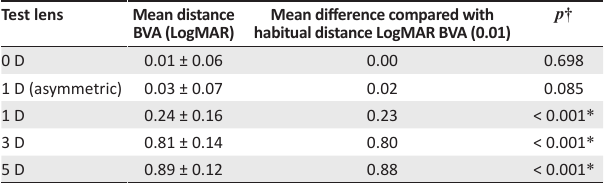
TABLE 1: Mean distance LogMAR BVA with the five test lenses used to induce optical defocus. Test lens Mean distance Mean difference compared with BVA (LogMAR) habitual distance LogMAR BVA (0.01)